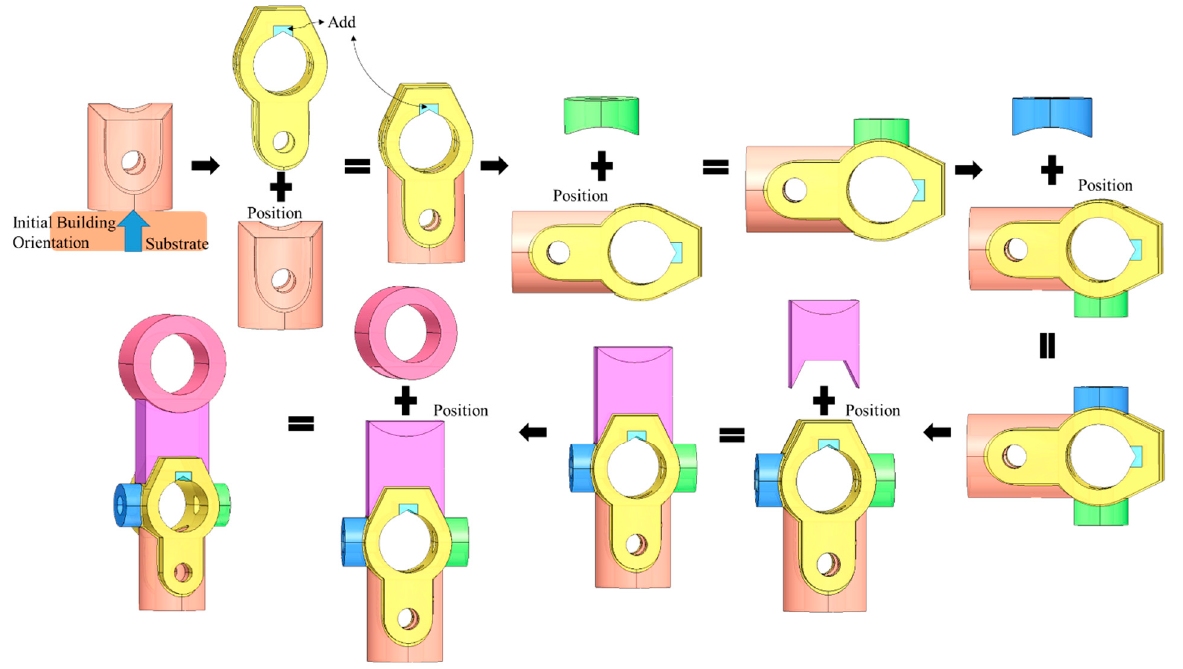
Figure 12. Process Planning with second defined initial building orientation for model (a).